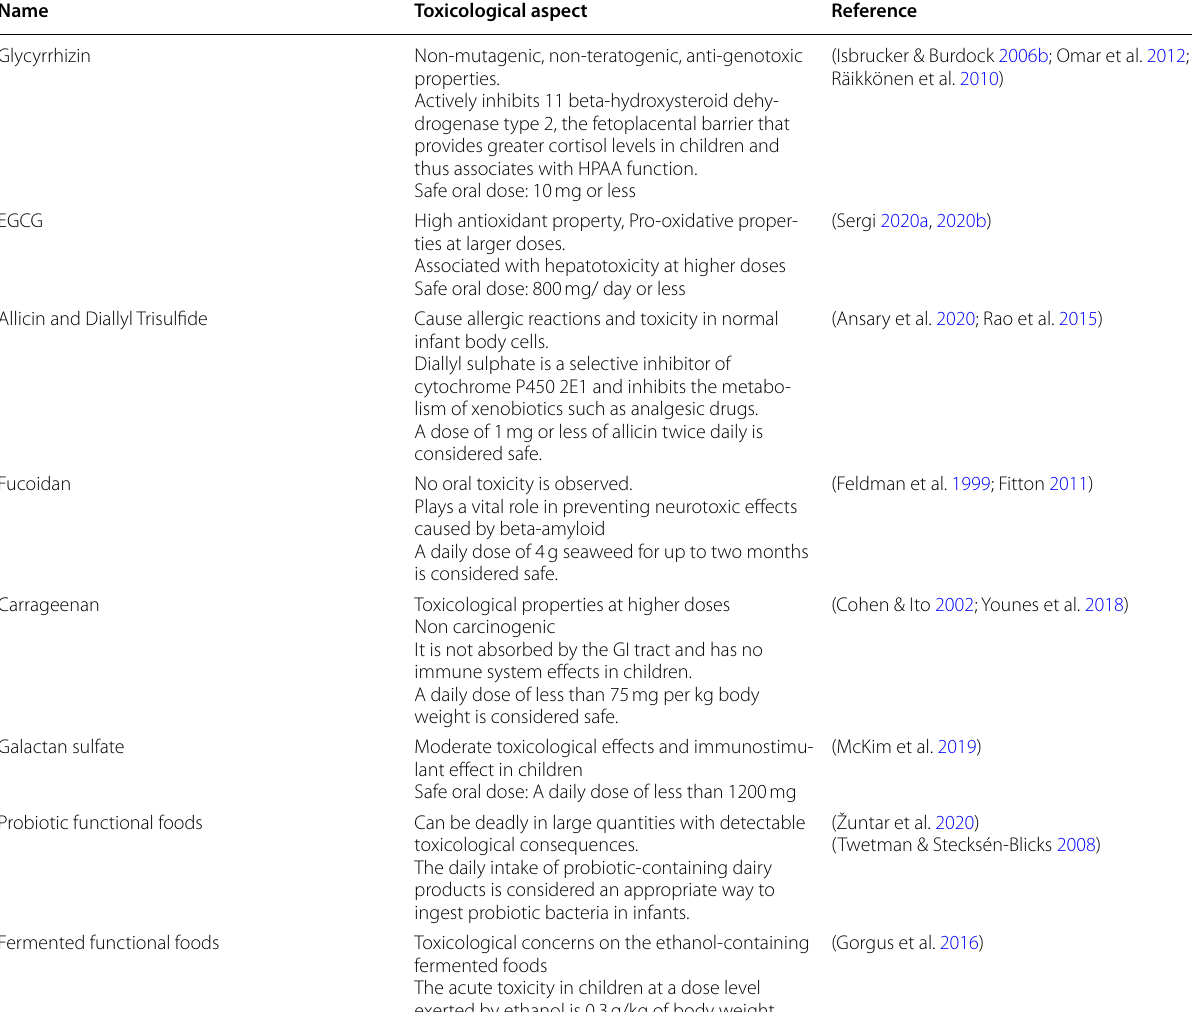
Table 3 Toxicological and dose considerations of functional food components Name Toxicological